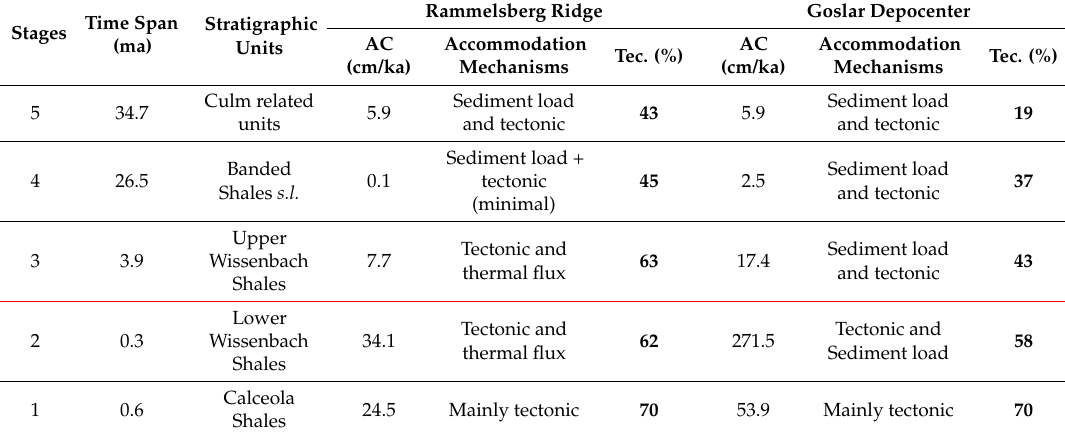
Table 1. Stages conforming the subsidence curves from Rammelsberg ridge and Goslar depocenter with indication of the accommodation rates and subsidence mechanisms proposed for each case. The red line specifies the location of the massive sulfides. Abbreviations: AC, Accommodation rates; Tec, Tectonic